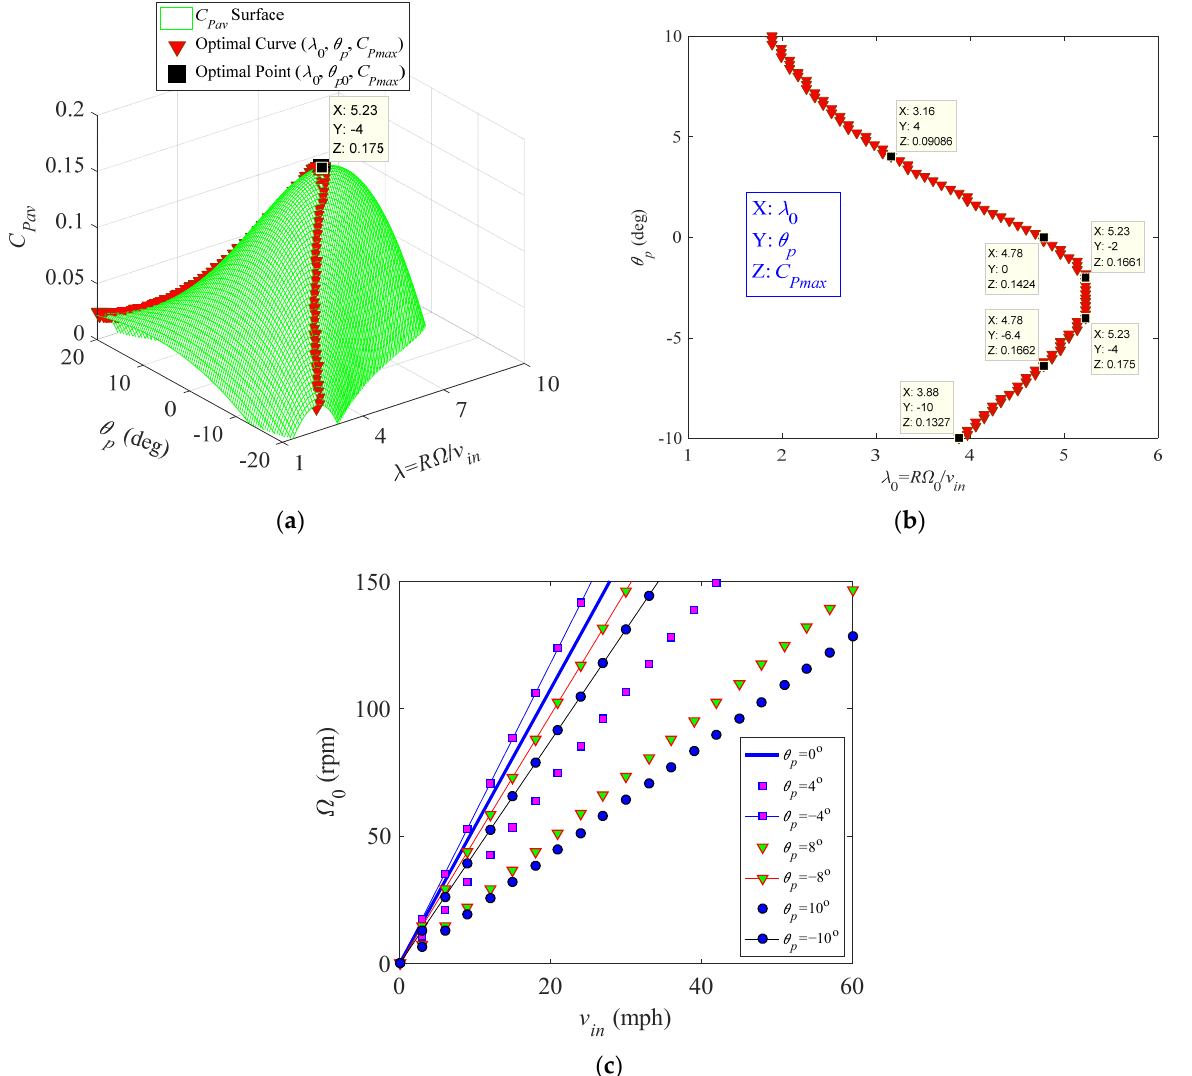
Figure 19. Variation of the power coefficient with the pitch angle, rotational speed, and wind speed: ( a ) three-dimensional surface; ( b ) two-dimensional projection of the optimal curve; and ( c ) variation rule of the optimal rotational speed with the pitch and wind speed.